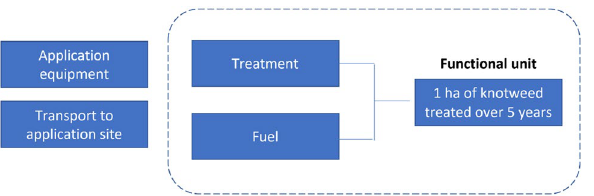
Figure 1. General system boundaries for this comparative LCA. Composition of each treatment is detailed in Table